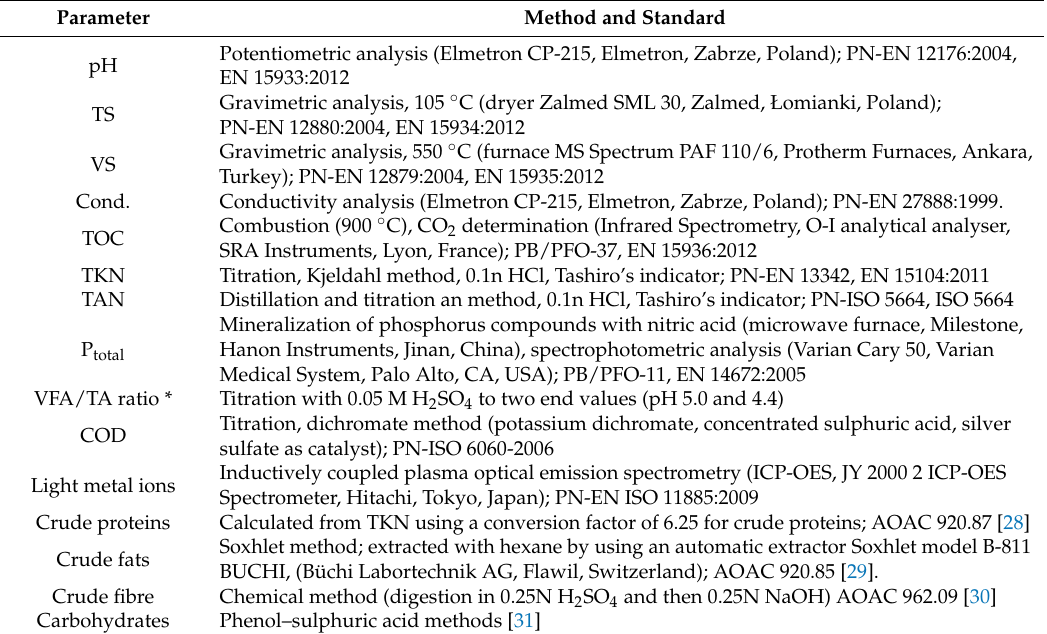
Table 3. Analytical